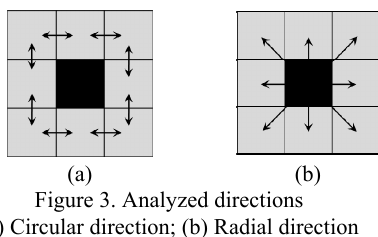
Figure 3. Analyzed directions (a) Circular direction; (b) Radial